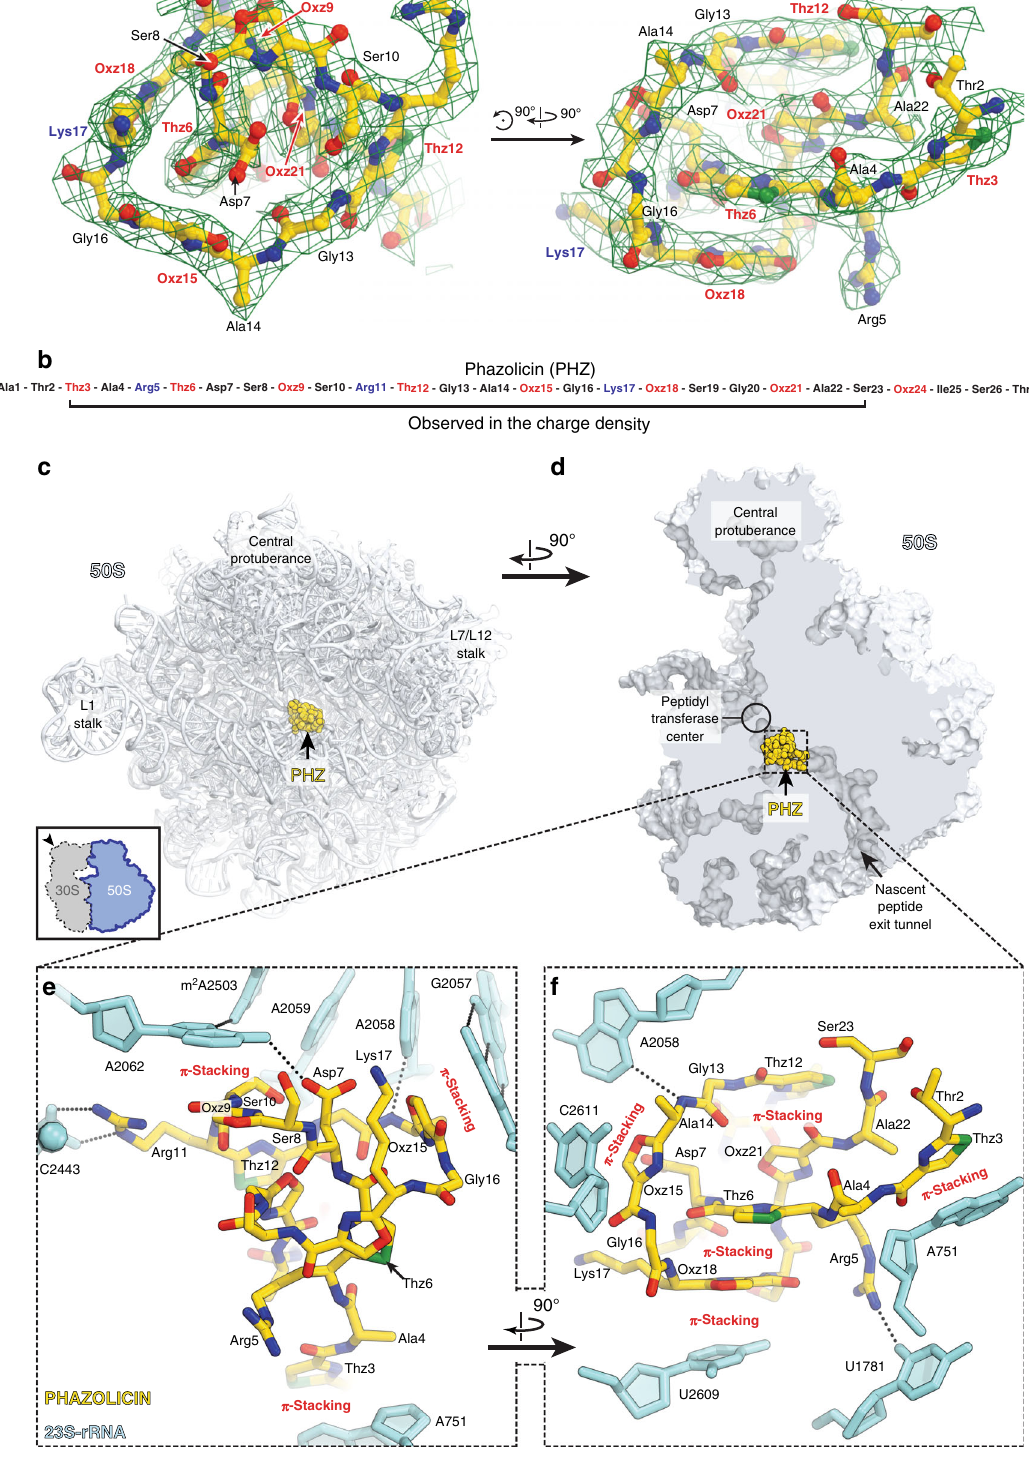
Fig. 3 The structure of PHZ in complex with the bacterial ribosome. a Cryo-EM map of PHZ in complex with the E. coli 70S ribosome (green mesh). The fi tted model of the compound is displayed in its respective charge density viewed from two different perspectives. The map is contoured at 2.5 σ . Carbon atoms are colored yellow, nitrogen atoms are blue, oxygen atoms are red, and sulfur atoms are green. b Schematic diagram showing that only residues 2 – 23 of the ribosome-bound PHZ molecule are visible in the cryo-EM map. c , d Overview of the PHZ-binding site (yellow) on the E. coli large ribosomal subunit (light blue) viewed from two different perspectives. In c , the 50S subunit is viewed from the inter-subunit interface (30S subunit is removed for clarity) as indicated by the inset. The view in d is from the cytoplasm onto the A site. e , f Close-up views of the PHZ-binding site in the ribosome exit tunnel. E. coli numbering of the nucleotides in the 23S rRNA is used. Potential H-bond interactions are indicated with dotted